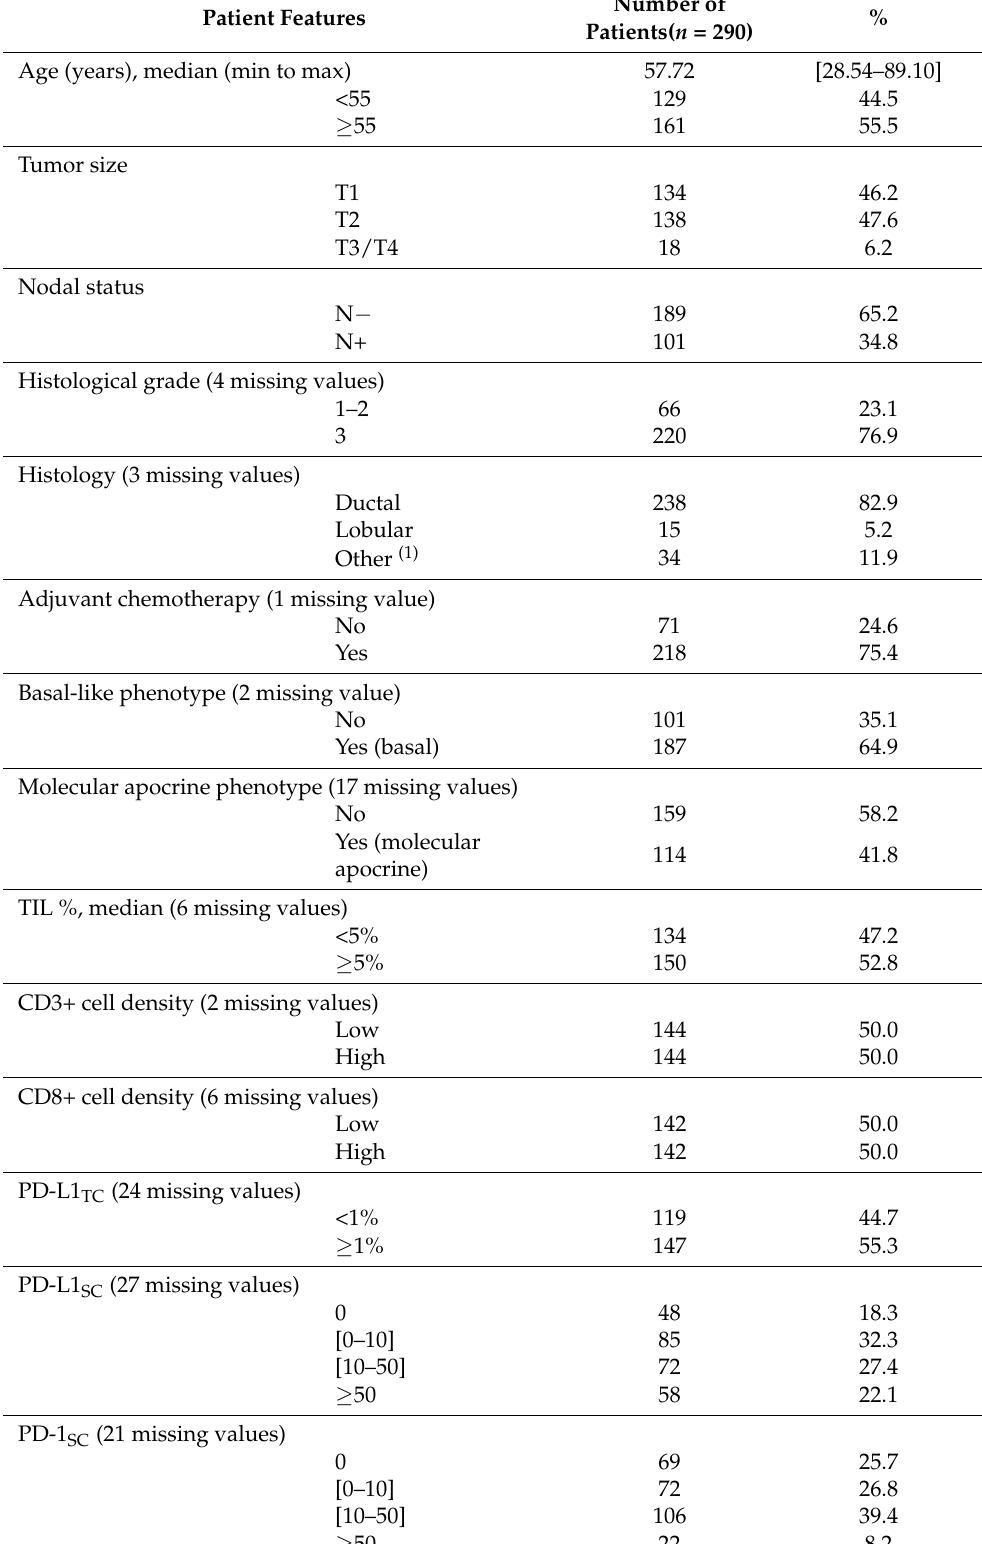
Table 1. Clinicopathological characteristics of the studied population ( n =